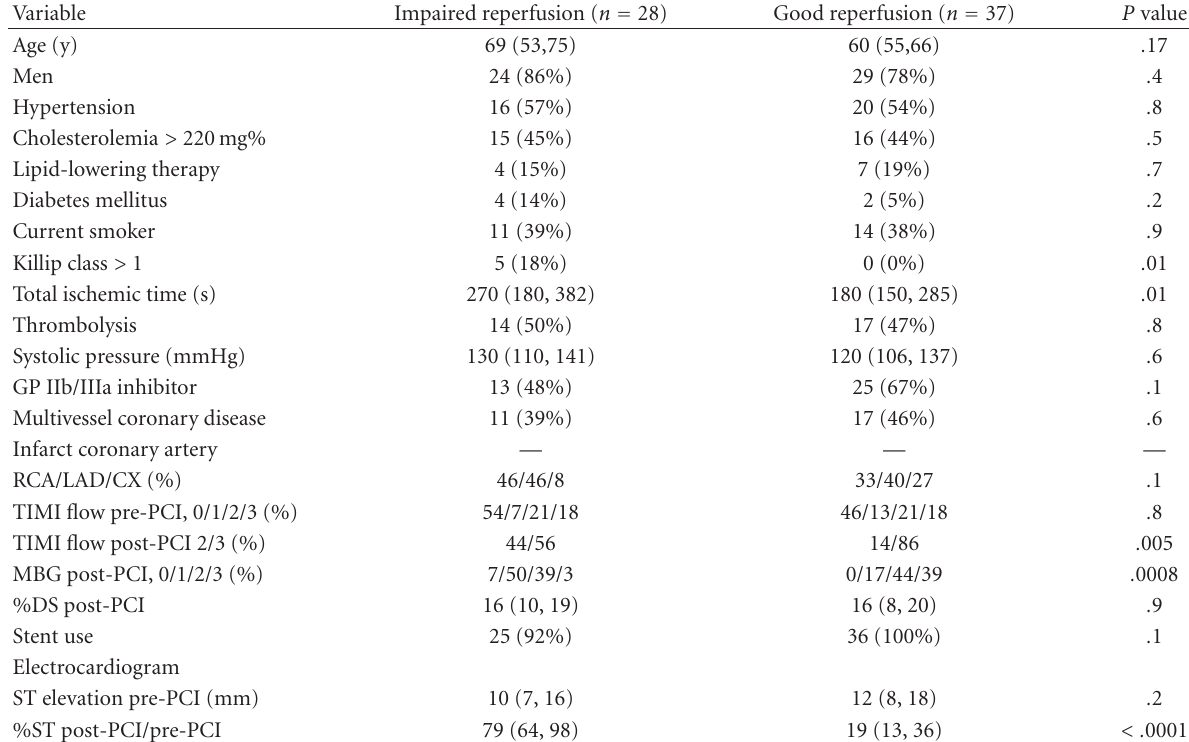
Table 1. Baseline characteristic. Data are presented as median value with 25th and 75th